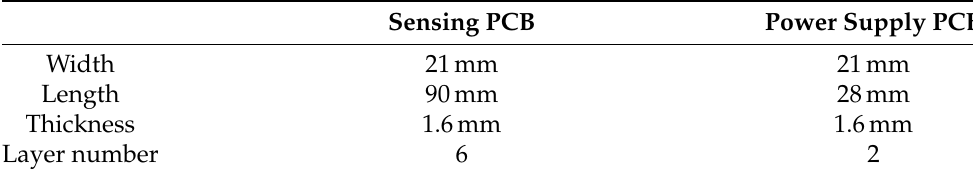
Figure 3. Manufactured PCBs: sensing board ( left ) and power supply board ( right ). Table 1. Main features of the manufactured